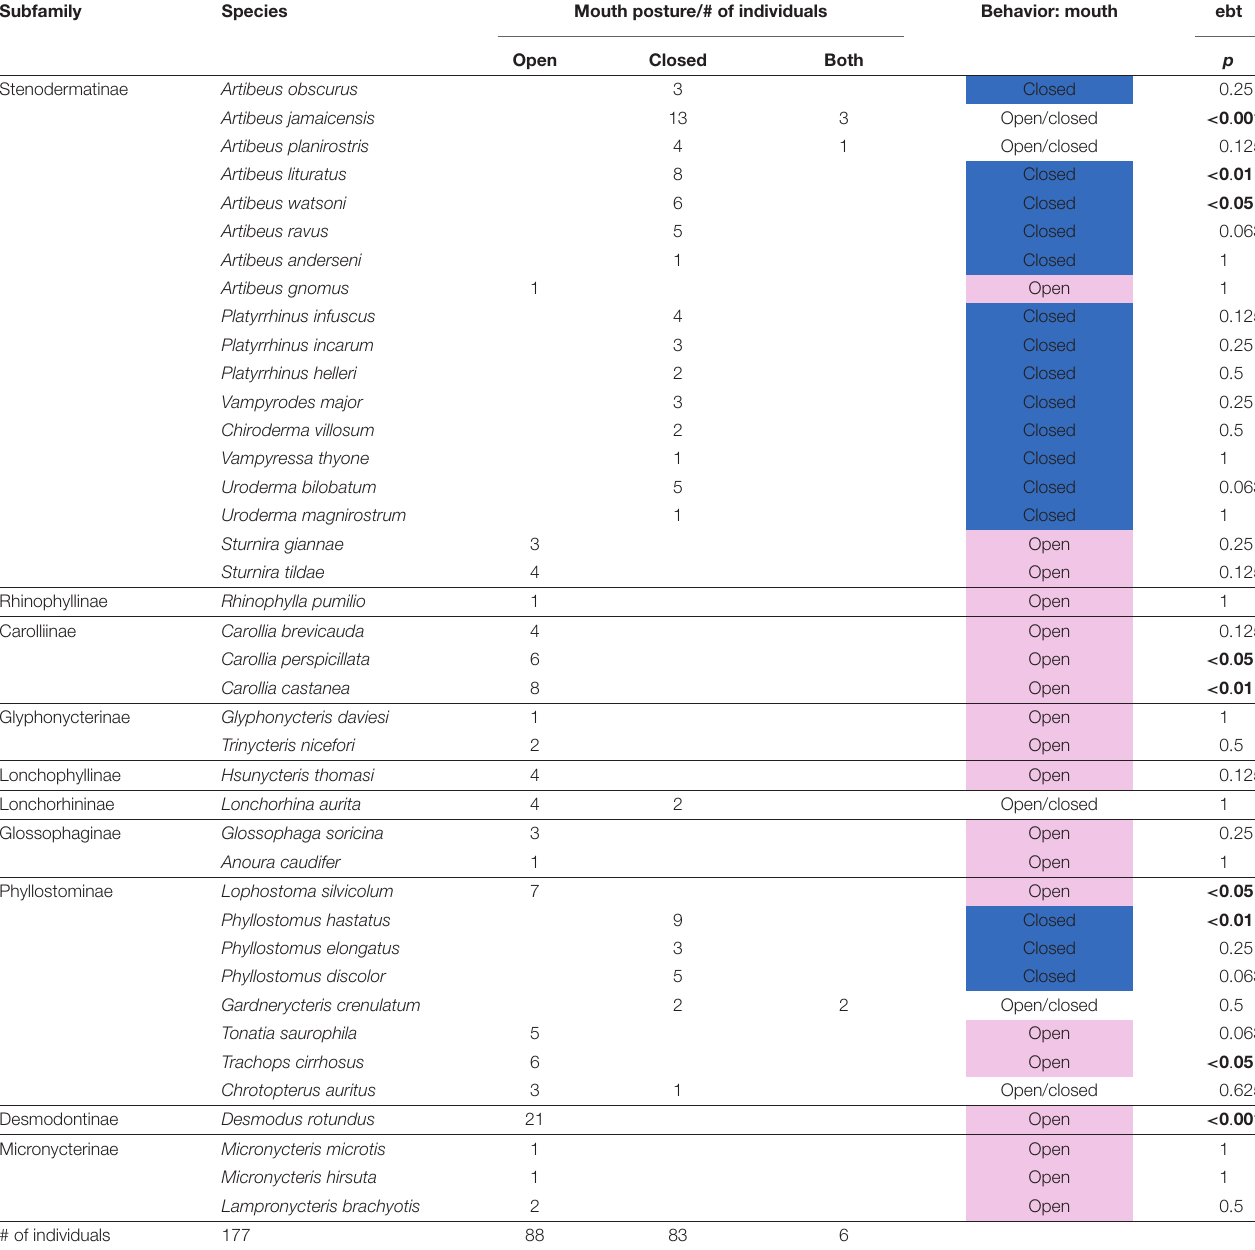
TABLE 1 | Scoring of the mouth posture of 40 phyllostomid species during flight (mean number of sequences scored per individual: 2). Subfamily Species Mouth posture/# of individuals Behavior: mouth ebt